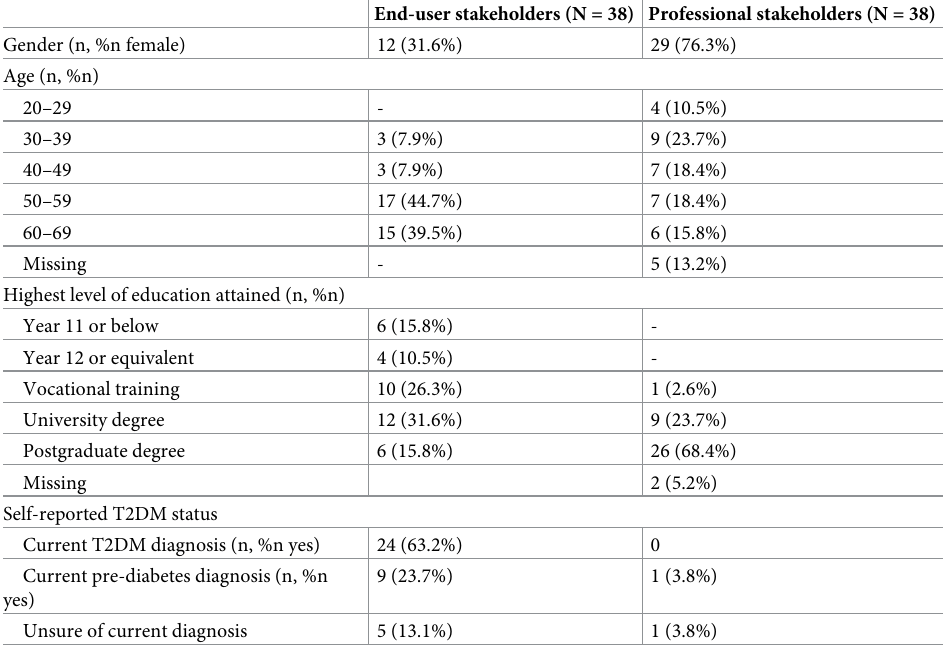
Table 1. Participant